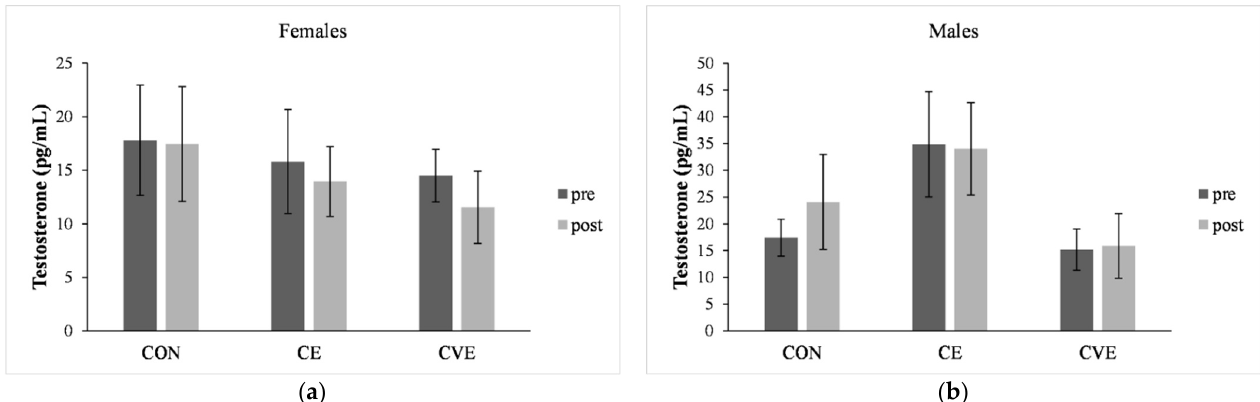
Figure 1. Pre ‐ and post ‐ test means of testosterone concentration in females ( a ) and males ( b ) are shown for the control group (CON), the coordinative exercise (CE), and the cardiovascular exercise (CVE) group. Error bars represent 95% confidence intervals for the mean.